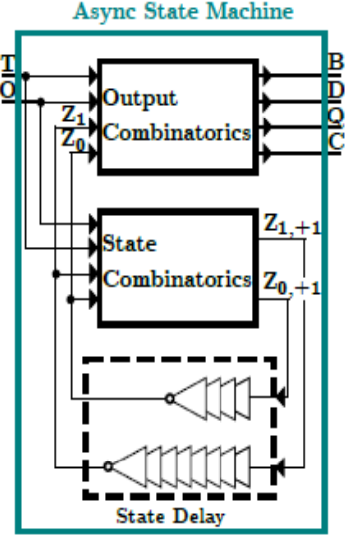
Figure 14. Block diagram of the asynchronous state machine.